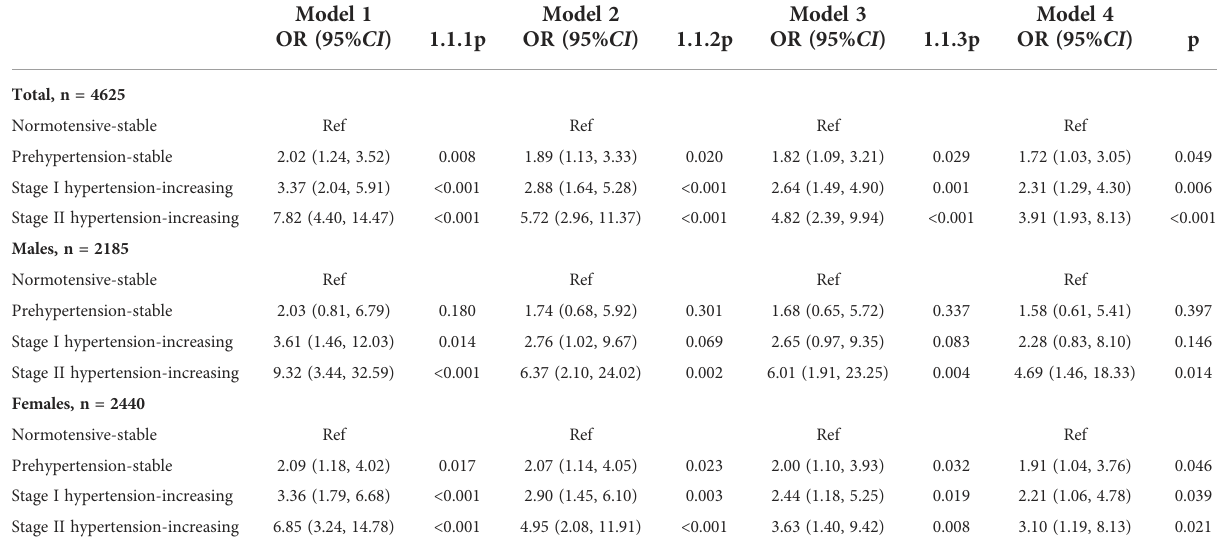
TABLE 2 Odds ratios and 95% CIs for trajectories of SBP groups for incident